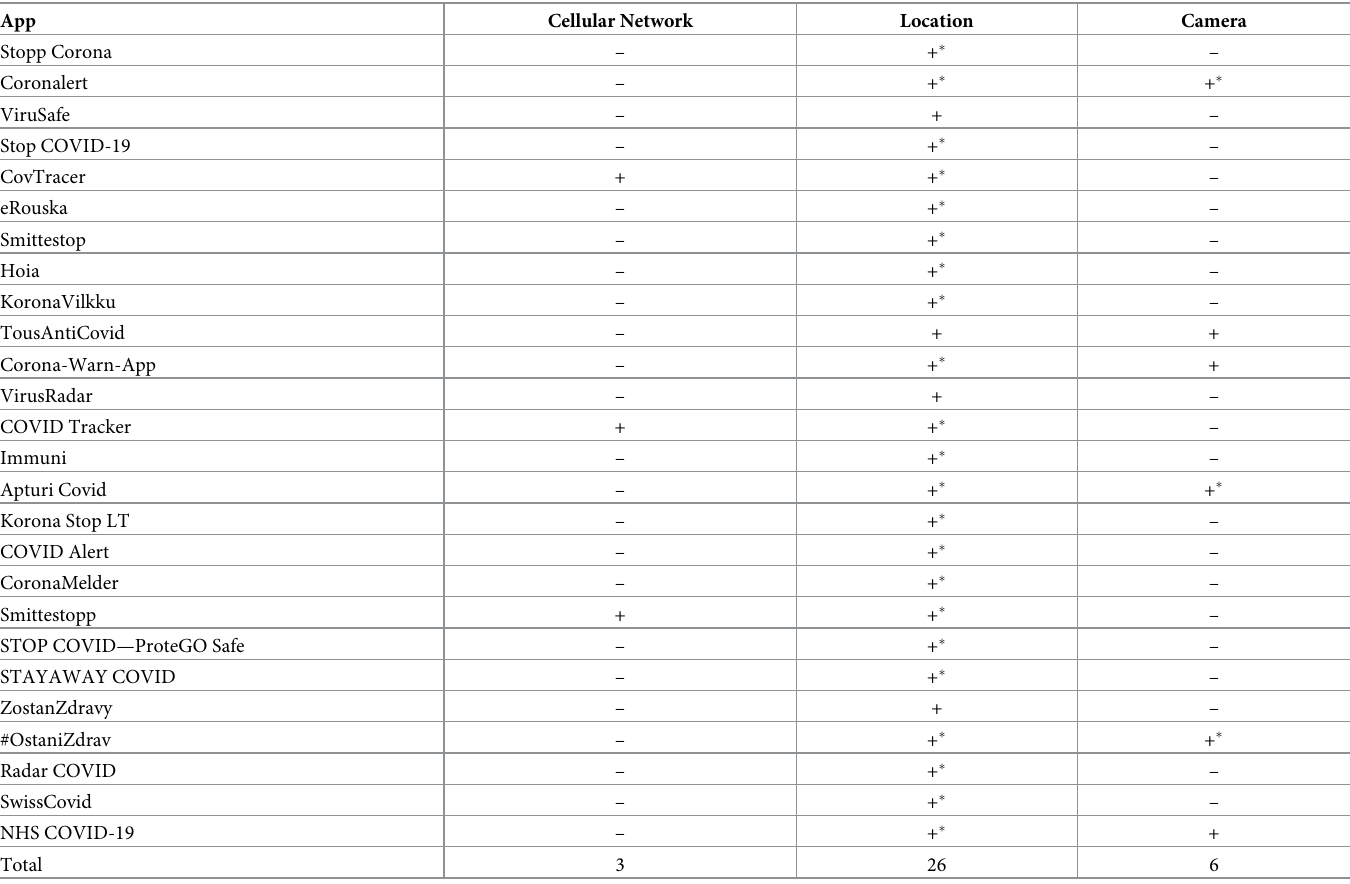
Table 5. Potentially privacy-invasive API call groups per